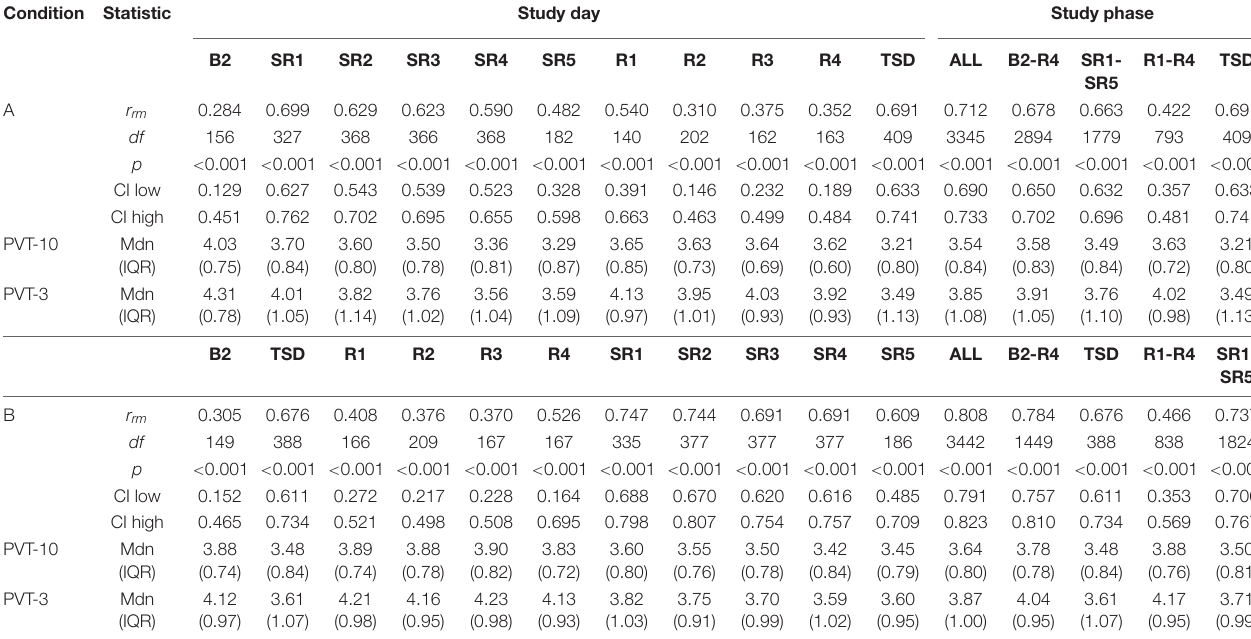
TABLE 3 | PVT-10 and PVT-3 1/RT rmcorr results by day and by study phase. Condition Statistic